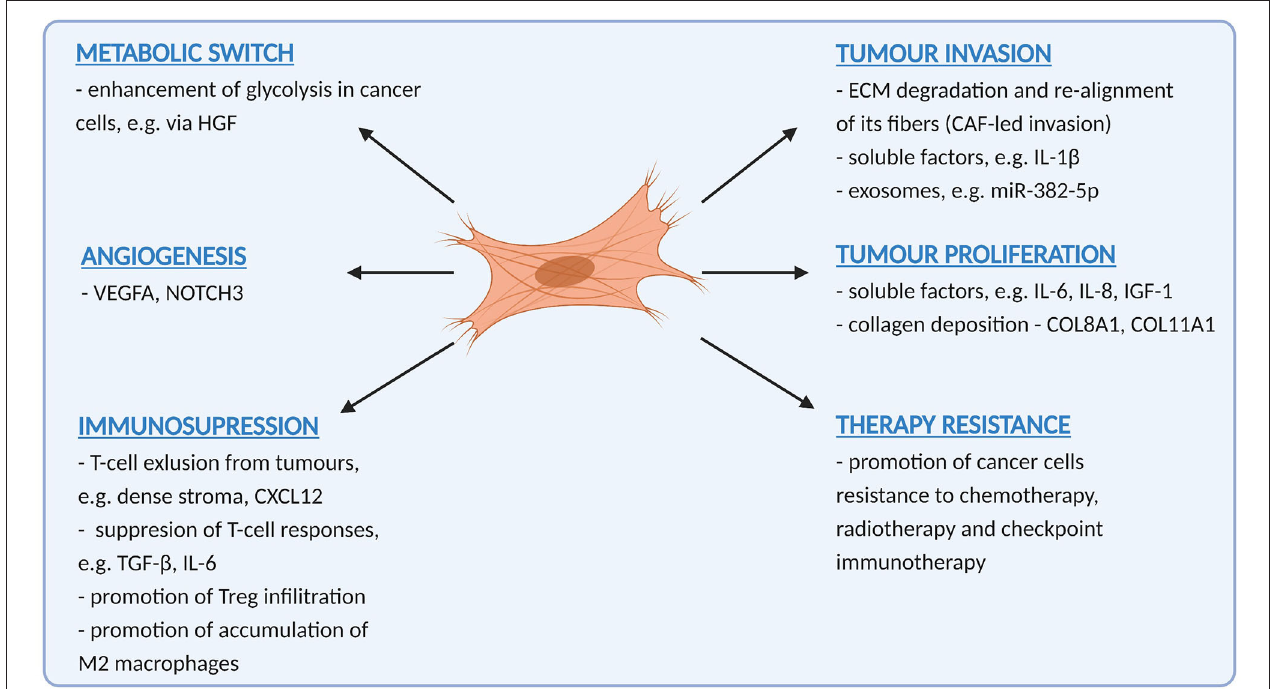
FIGURE 1 | A summary of pro-tumoural functions exerted by cancer-associated fibroblasts in oral cancer (Created with